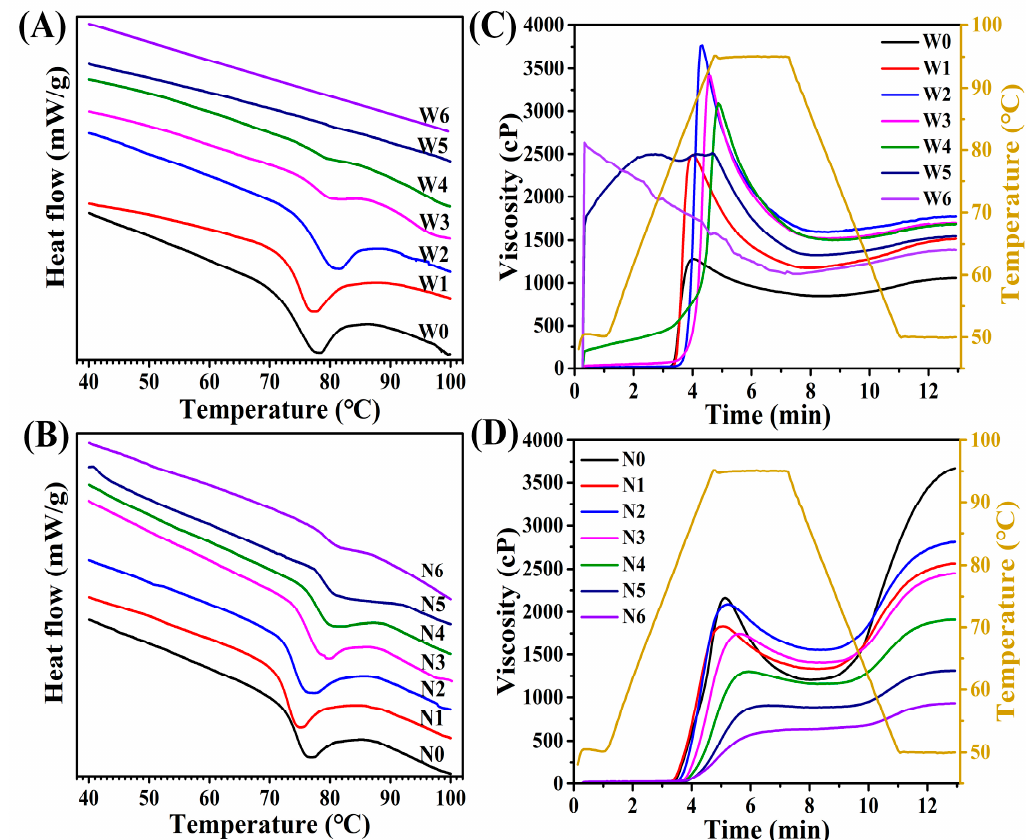
Figure 7. Thermal property (DSC) curves ( A, B ) and pasting property (RVA) patterns ( C, D ) of uncooked and cooked proso millet flours. W0–W6: Uncooked and cooked (5, 10, 15, 20, 25, and 30 min) of waxy proso millet flour, respectively; N0–N6: Uncooked and cooked (5, 10, 15, 20, 25, and 30 min) non-waxy proso millet flour,